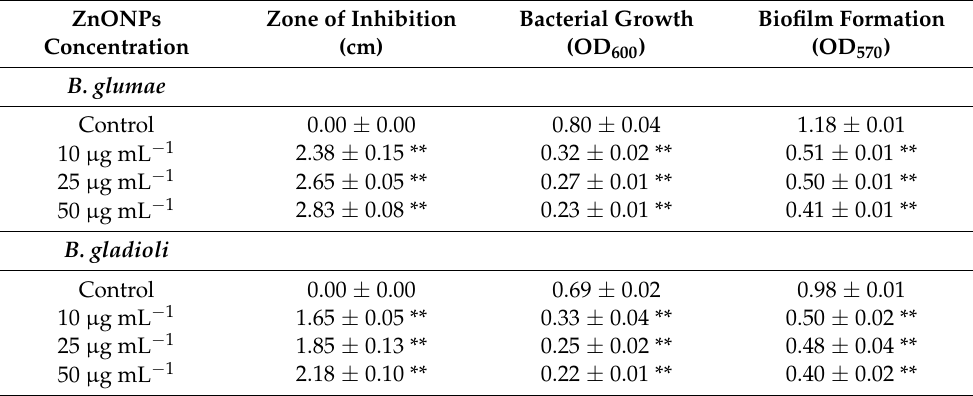
Table 2. In vitro antibacterial activity of biogenic ZnONPs against rice pathogens against B. glumae and B. gladioli .